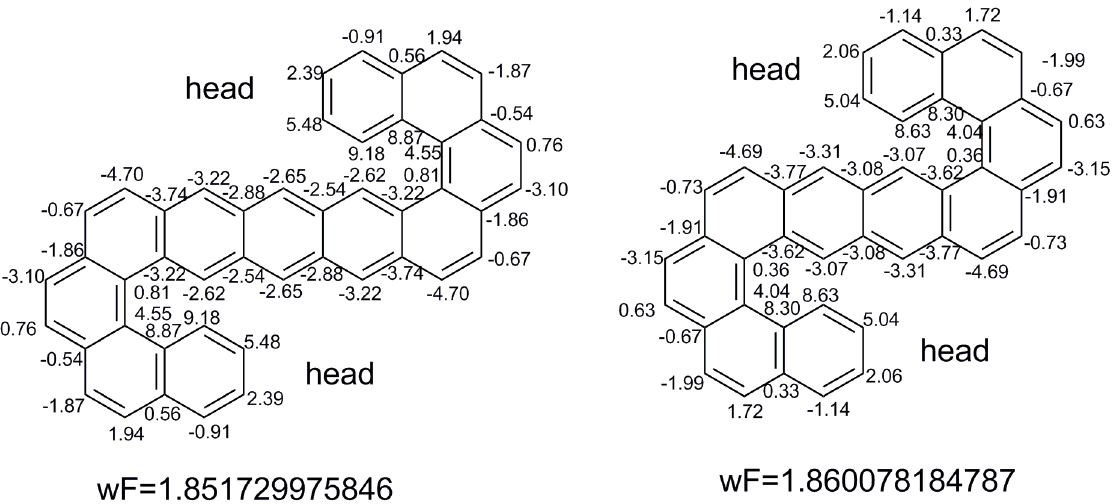
Figure 10. The benzenoids possessing the largest weighted F indexes for benzenoids size of 10 and 11. All the weighted atomic sums are